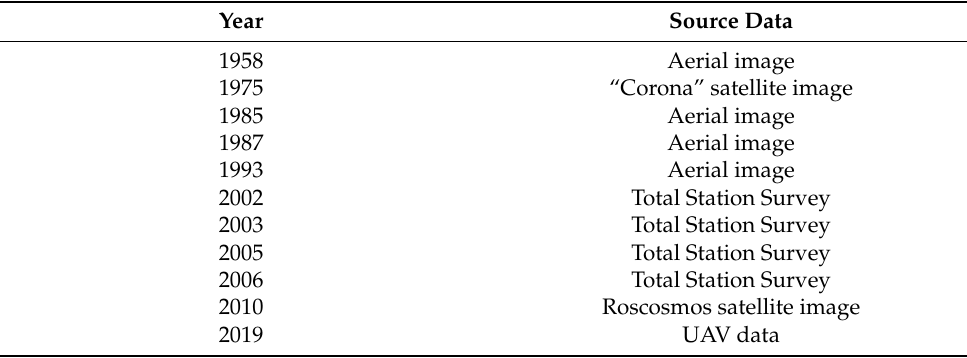
Table 4. Dates and data acquisition techniques and sources for Site